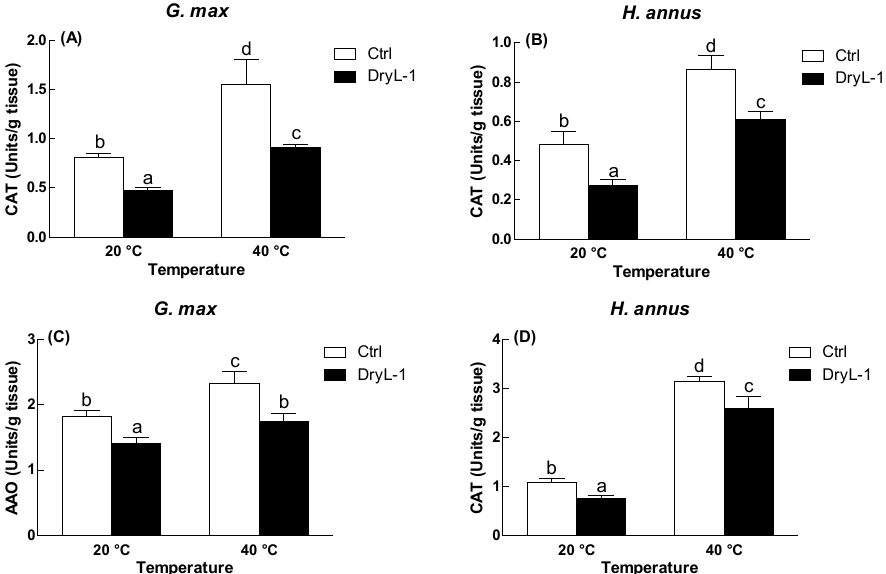
Fig. 4: Influence of A. violaceofuscus on the concentrations of AAO (A, B) and CAT (C, D) in G. max and H. annuus plants grown at normal (25 °C) and high (40 °C) temperatures. Data are means of triplicate with standard error bars. Different letters are significantly different (p < 0.05) as estimated by Duncan’s Multiple Range Test (DMRT).